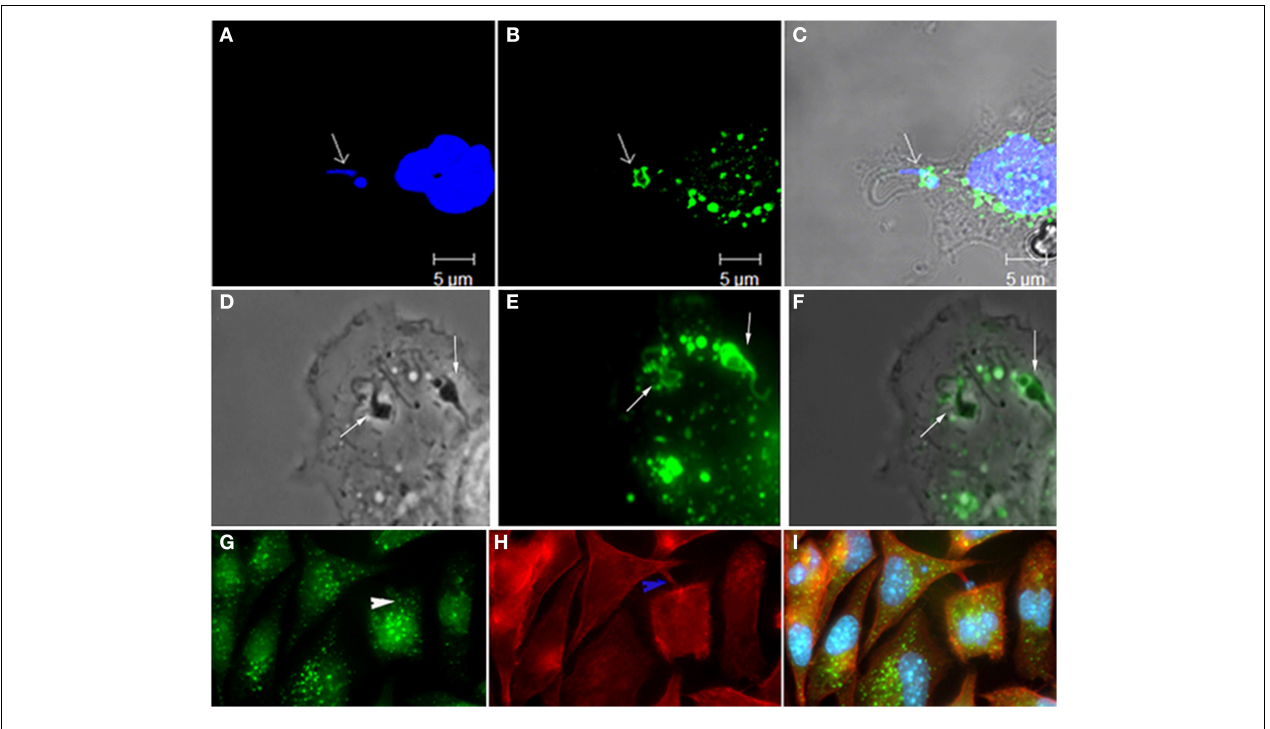
FIGURE 1 | Participation of Rabankirin 5 (A, DAPI; B, Rabankirin; C, merge), lucifer yellow (D, phase; E, lucifer yellow; F, merge), and actin+rabankirin (G, rabankirin; H, phaloidin Alexa 546, I, merge) in the entry of T. cruzi and formation of the parasitophorous vacuole.